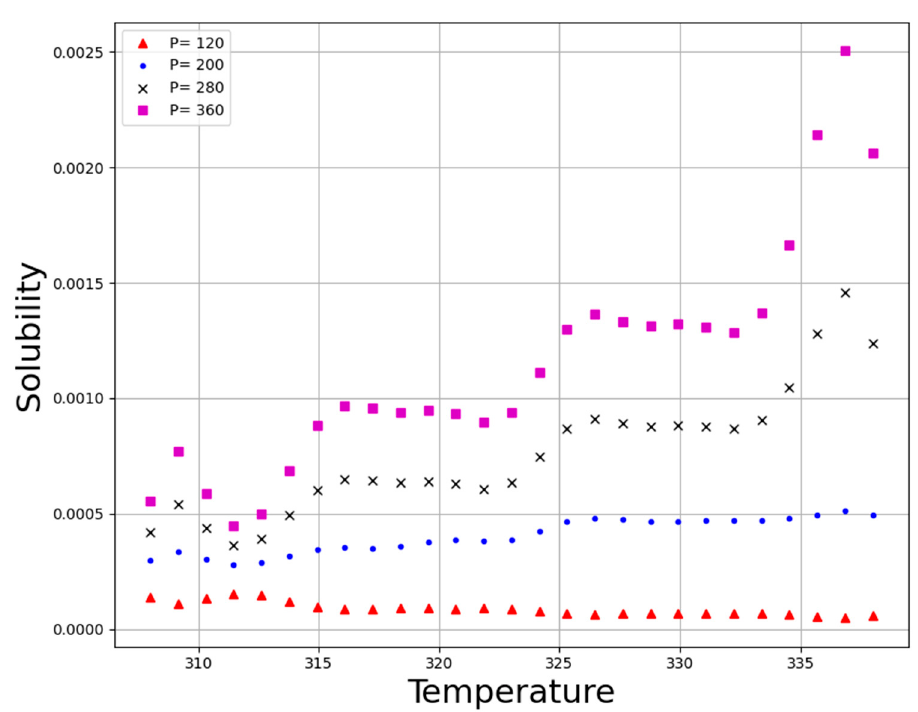
Figure 7. Tendency of T . Table 3. Optimal values (GBRT Model) .